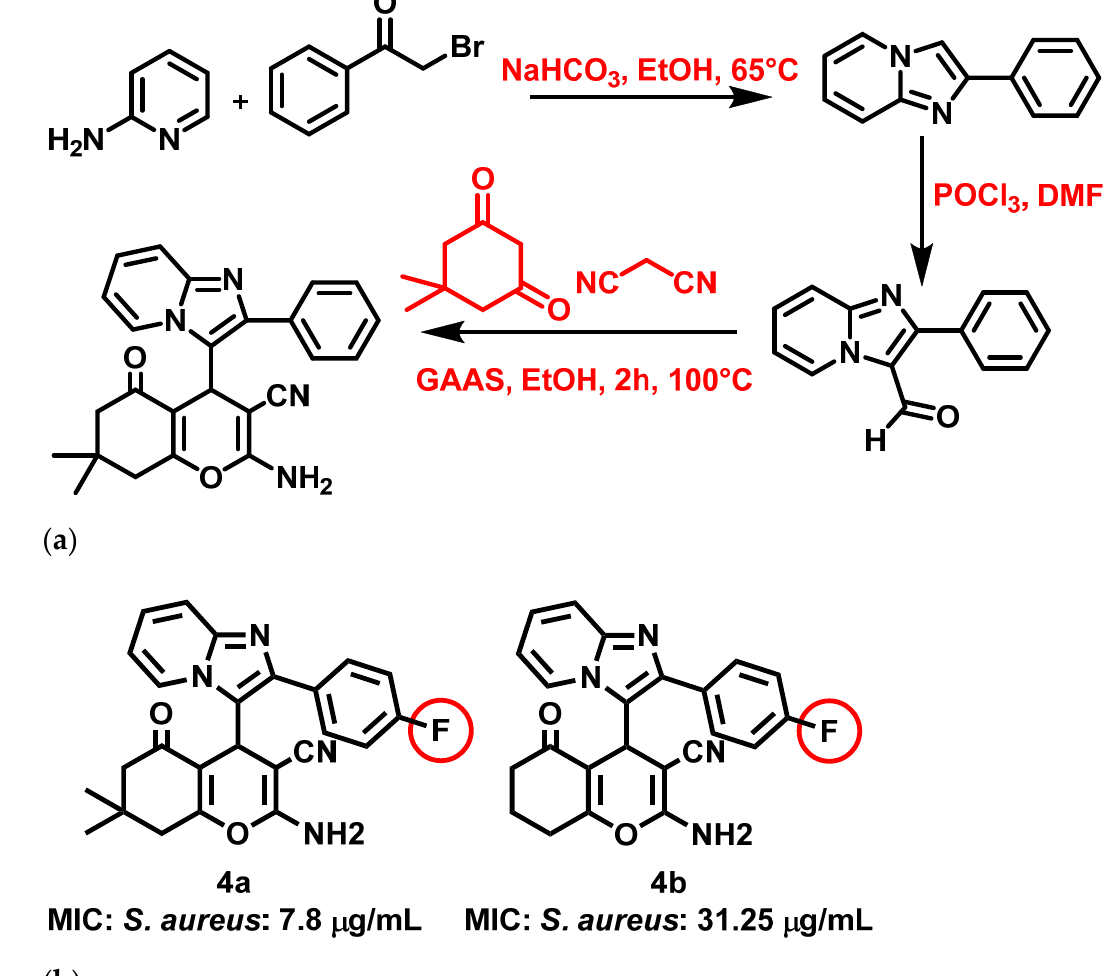
Figure 5. ( a ) Synthesis of 2-phenylimidazo [1,2-a] pyridine-based pyran bis-heterocycles. Signatures of compounds according to Thakur et al., 2020 [59]. ( b ) Imidazopyridine conjoined pyran bis-heterocyclic derivatives. Signatures of compounds according to Thakur et al., 2020 [59]. At the same time Salhi et al., 2019 [61], reported dihydro-IZPs as potential antibac- terial agents against wild and resistant bacterial strains such as E. coli , P. aeruginosa , S. aureus , Enterococcus faecalis ( E. faecalis ), MRSA, and Methicillin-Resistant Micrococcus luteus (MRML). Salhi synthesized these compounds using maleimide as a starting